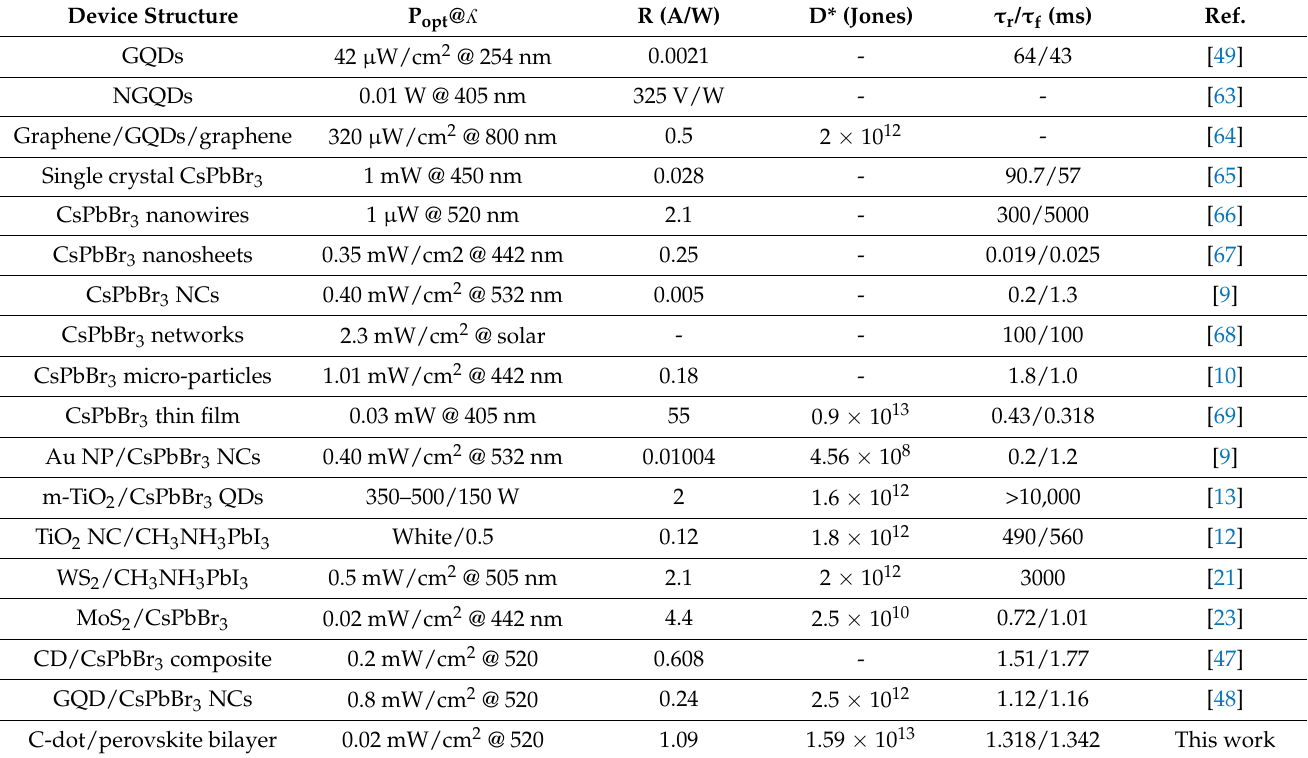
Table 3. Performance comparison of the